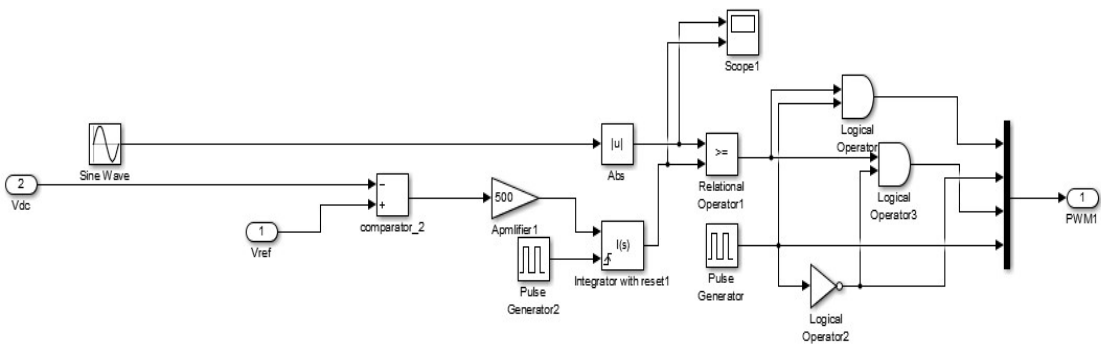
Figure 14. Inverter controller design to control SPWM signal.